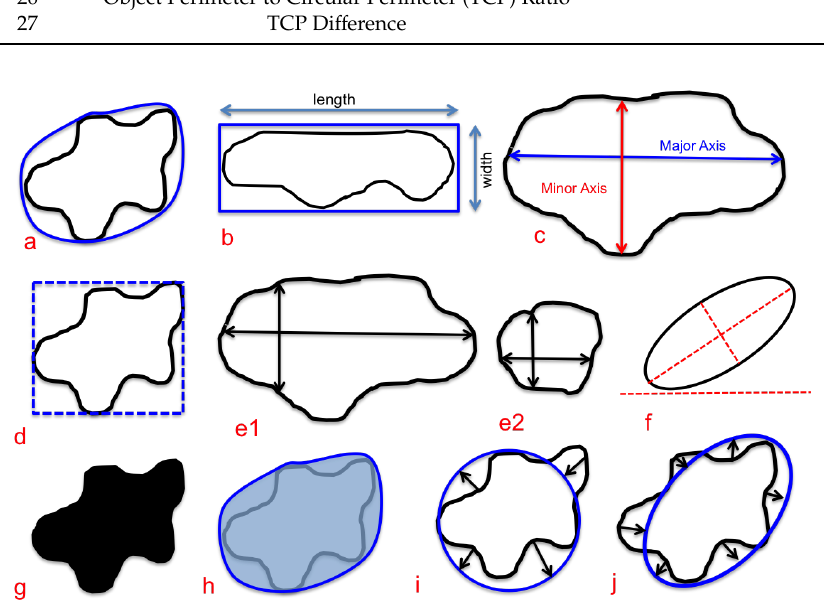
Figure 3. Visual depiction of geometric and morphological features. ( a ) Convexity, ( b ) elongation, ( c ) major and minor axes, ( d ) bounding box, ( e1 , e2 ) different instances of eccentricity, ( f ) orientation, ( g ) filled area, ( h ) convex area, ( i ) circular variance and ( j ) elliptical variance.